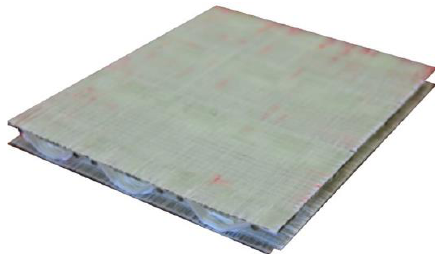
Figure 14. Finished Digitally Manufactured Navtruss Sandwich Panel.